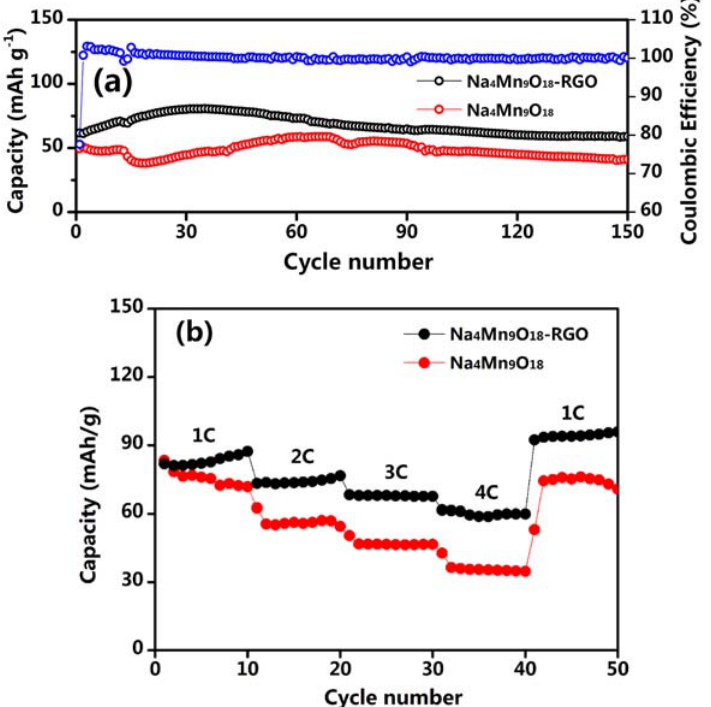
Figure 7. ( a ) Cycling performance of the Na 4 Mn 9 O 18 -RGO and Na 4 Mn 9 O 18 electrodes at 4 C and coulombic efficiency of the Na 4 Mn 9 O 18 -RGO electrode. ( b ) Rate capability of the Na 4 Mn 9 O 18 -RGO and Na 4 Mn 9 O 18 electrodes.